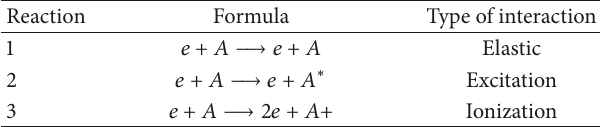
Table 1: Plasma-chemical reactions taken into consideration.